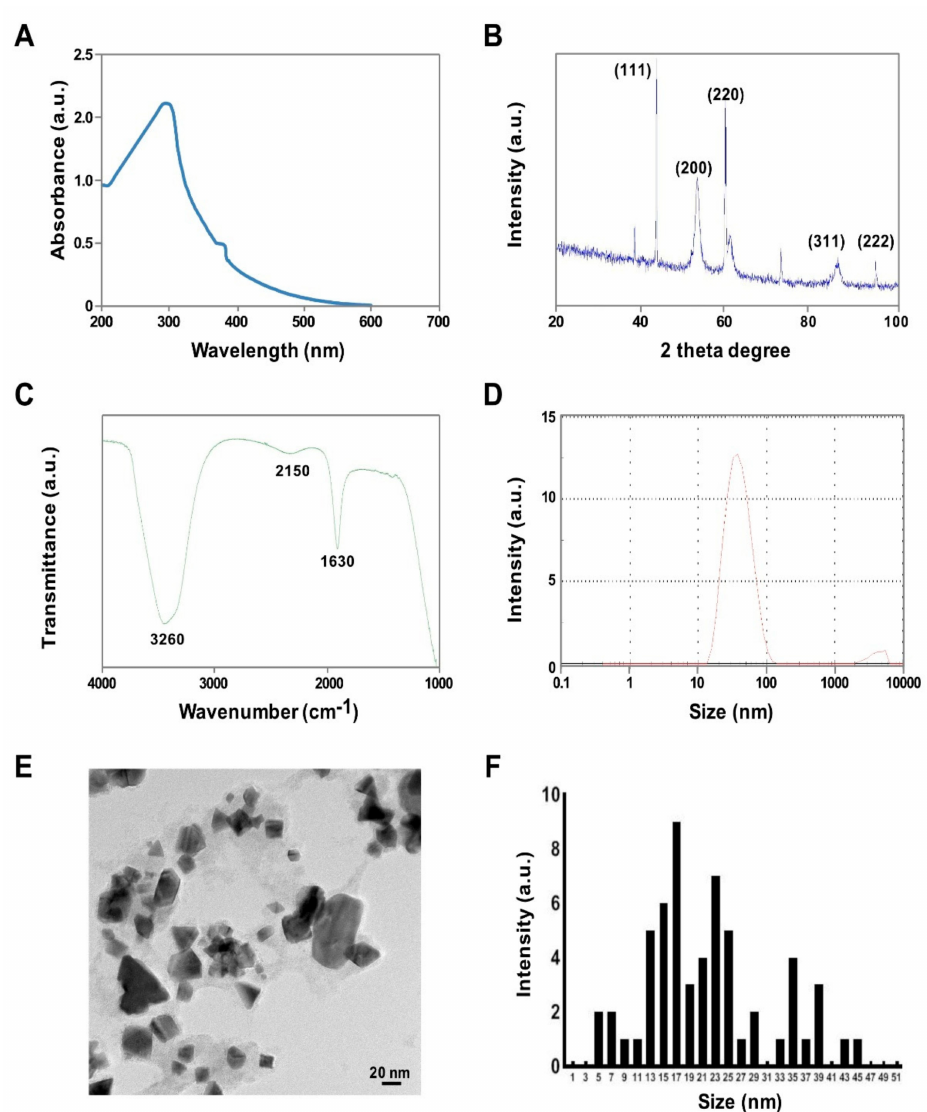
Figure 1. Synthesis and characterization of PtNPs using tangeretin. ( A ) Absorption spectra of tangeretin-mediated PtNP synthesis; the absorption spectra of PtNPs exhibited a strong broad peak at 304 nm, and observation of such a band is assigned to surface plasmon resonance of the particles. ( B ) X-ray di ff raction patterns of PtNPs; the broad di ff raction peaks of the XRD pattern at 2 θ = 40.0, 47.6, 67.5, 81.8, and 88.6 ◦ were observed ( C ) FTIR spectra of PtNPs; ( D ) size distribution analysis of PtNPs by DLS; ( E ) TEM micrograph images of PtNPs; several fields were photographed and used to determine the diameter of AgNPs using TEM; and ( F ) corresponding particle size distribution histograms. At least three independent experiments were performed obtaining reproducible results and data from representative experiments are